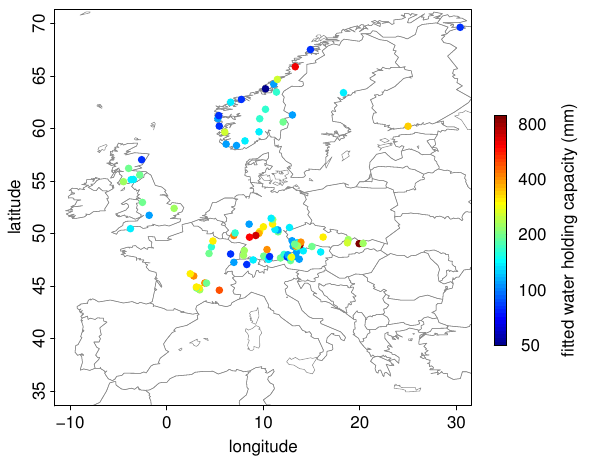
Fig. 3. Fitted water holding capacities for the selected catchments. Figure 3: Fitted water holding capacities for the selected catchments. Note the logarithmic scale of the color- coding. Note the logarithmic scale of the colour-coding.